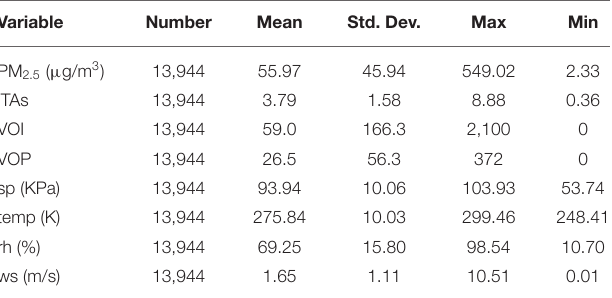
TABLE 1 | The descriptive statistics for each variable.